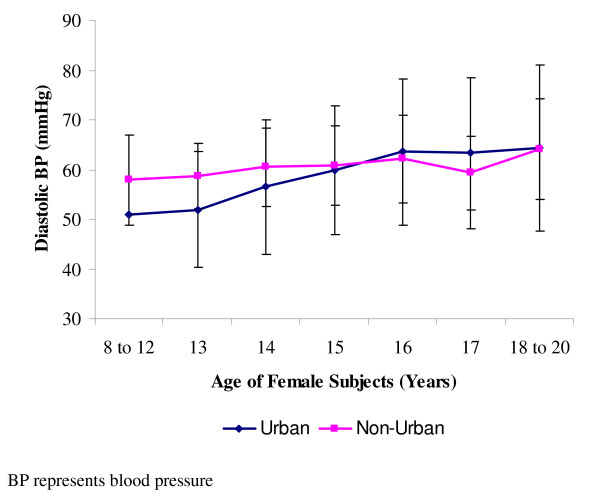
Mean diastolic blood pressures of female subjects. Data (mean ± standard deviation) are for systolic blood pressures of 473 females studied, and made up of 217 urban dwellers and 256 non-urban dwellers.